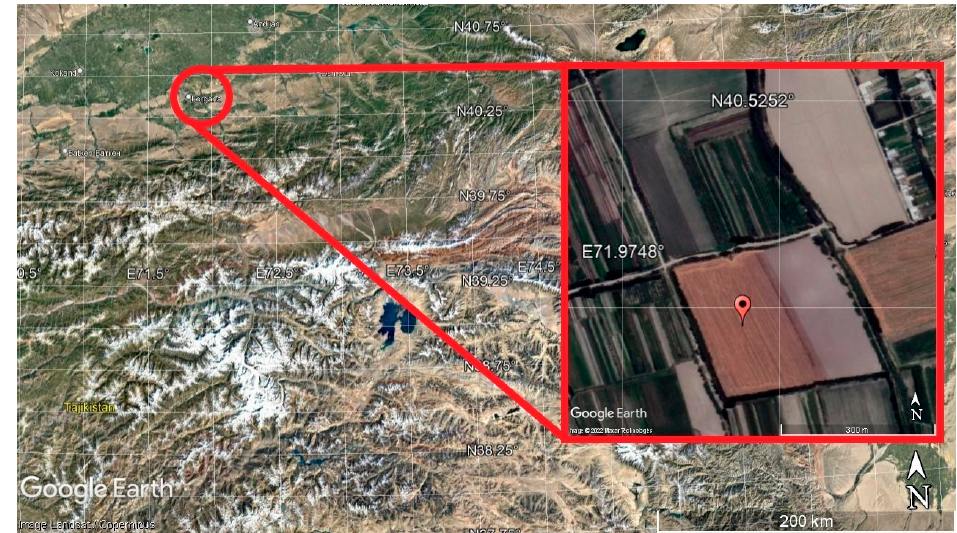
Figure 1. Location of the study area and the soil section of the irrigated meadow saz soil in the image from the Google Earth service.